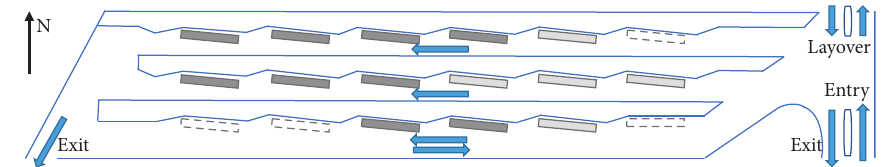
Figure 11: The bus terminal at Norrk¨oping interchange station. The filled squares, both dark and light grey show stops currently in use during normal operations. The dark grey filled squares show the stops in use in the reallocation of lines to stops